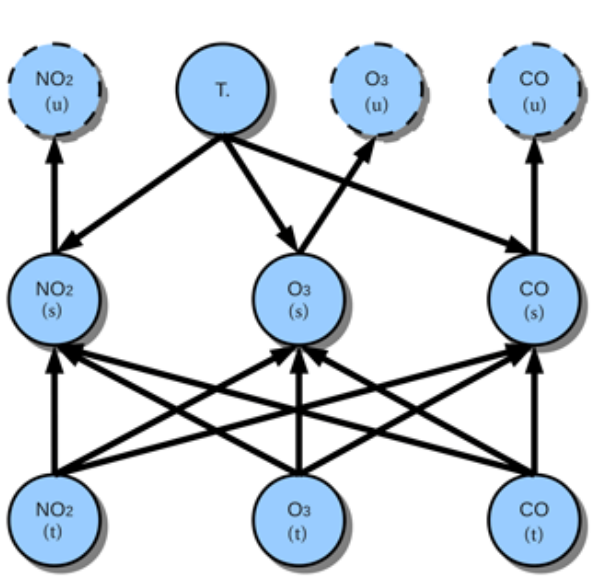
Figure 5. The Bayesian network with virtual nodes. (Symbol defi- nition in Sect.